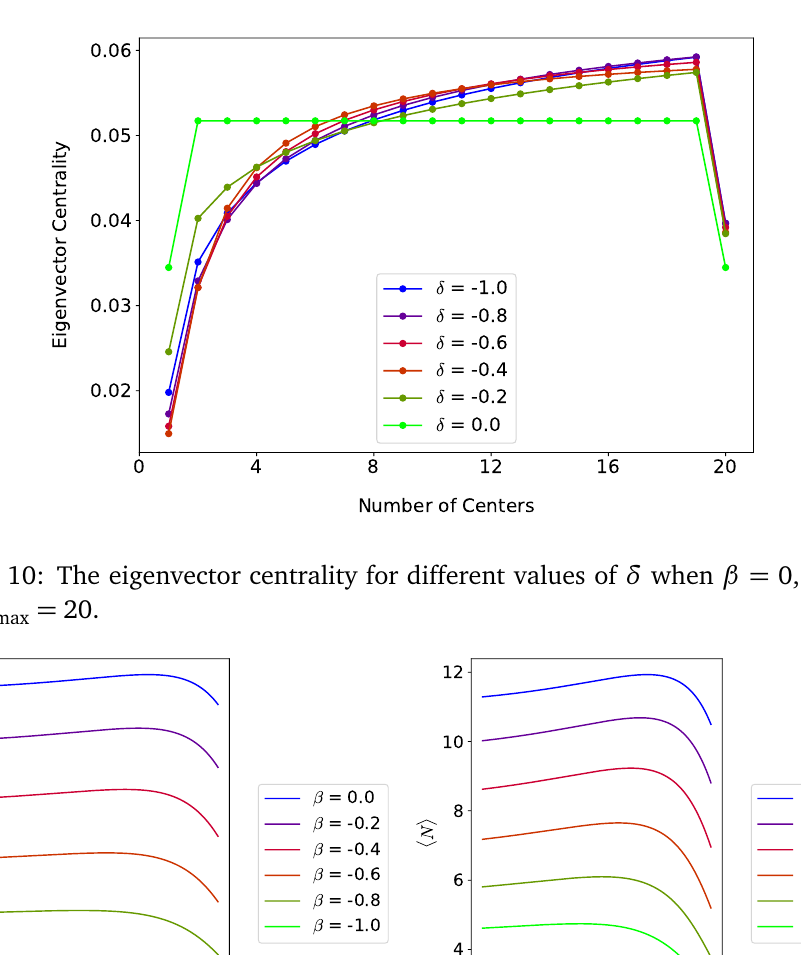
Figure 11: Plots of 〈 N 〉 versus δ for different values of β , with N